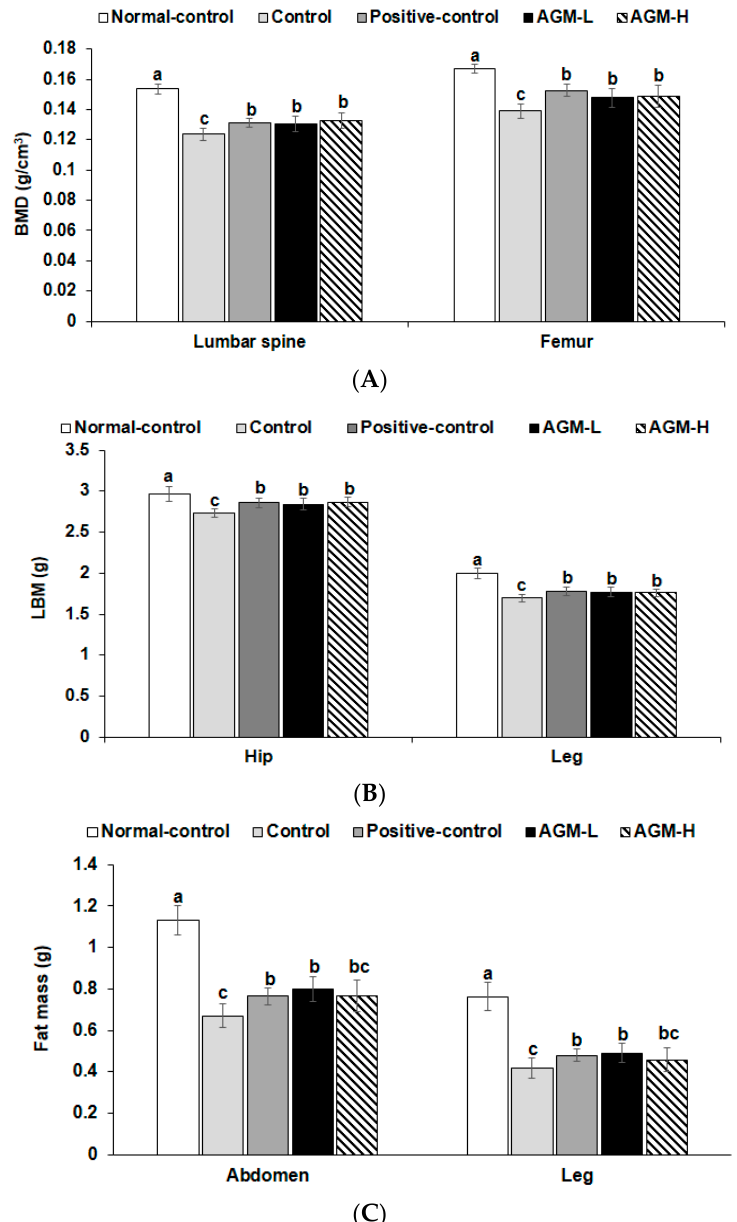
Figure 1. Bone mineral density (BMD), lean body mass (LMB) and fat mass (FM) at the end of experiment. Px rats were fed a high fat diet supplemented with aronia, red ginseng, shiitake mushroom, and nattokinase powders (1) 0.5 g mixture/kg bw/day (AGM-L), (2) 1 g mixture/kg bw/day (AGM-H), (3) 1 g dextrin/kg bw/day (control), or (4) metformin (120 mg/kg body weight; positive-control) for 12 weeks. Sham rats fed the same diet of control. BMD ( A ) in the lumbar spine and femurs, LBM ( B ) of the hip and legs and FM of the abdomen and legs ( C ) were measured by DEXA. Each bar and error bar represents the mean ± SD ( n = 10 of each group). a,b,c Different superscripts on the bars represent significant differences at p < 0.05.